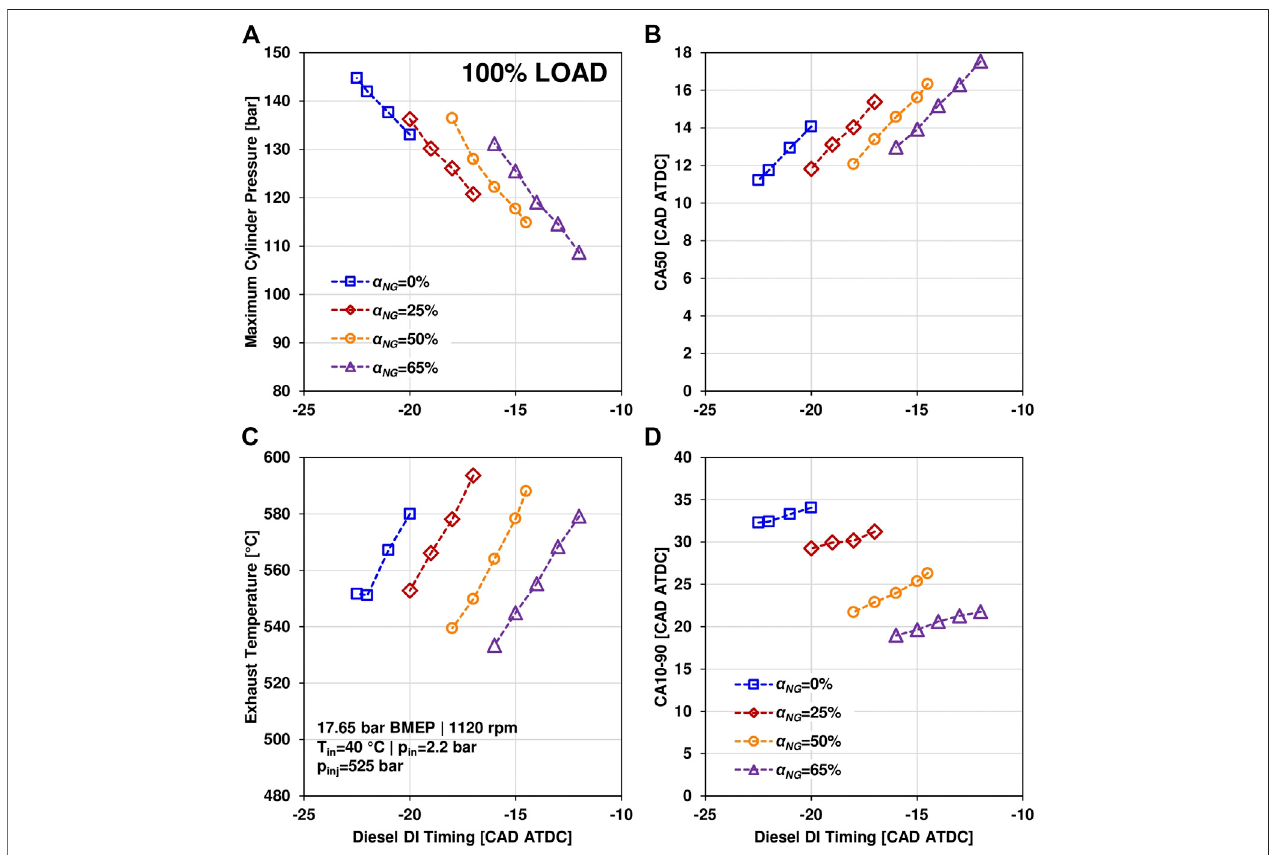
FIGURE 6 | 100% load results – (A) : Maximum cylinder pressure; (B) : CA50; (C) : Exhaust Temperature; (D) : CA10 –